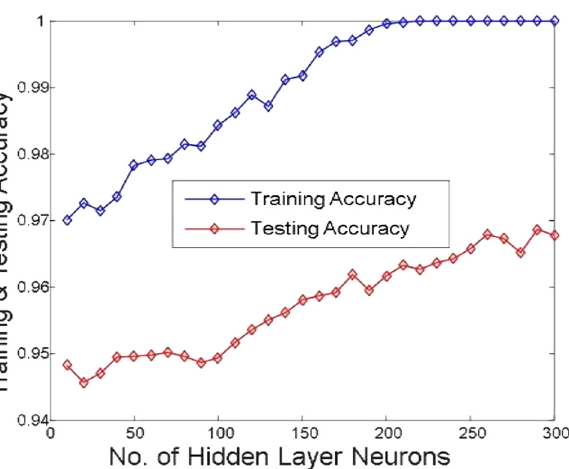
Figure 8: Hidden neurons versus training & testing accuracy